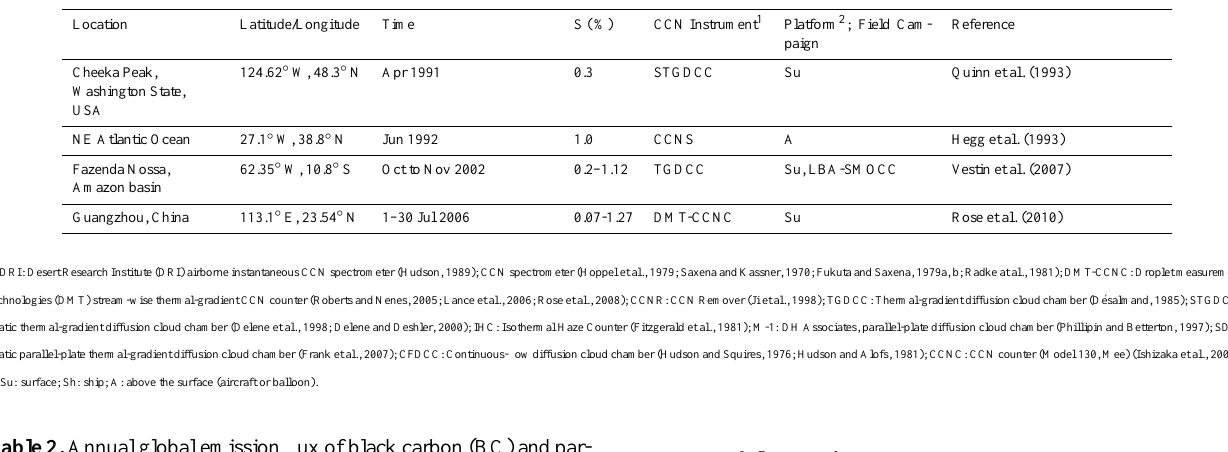
Table 2. Annual global emission flux of black carbon (BC) and par- ticulate organic matter (POM) for wildfire, biofuel and fossil fuel emissions. The numbers in parentheses indicate the percentage of total